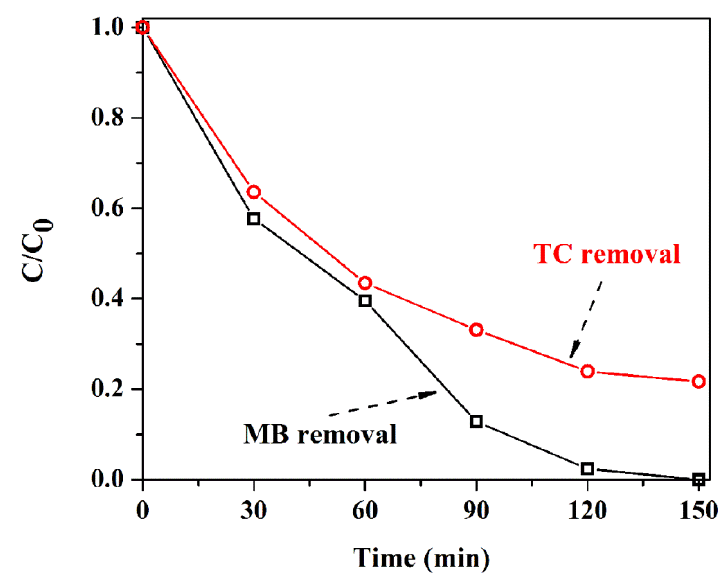
Figure 6. Methylene blue (MB) (20.0 mg / L, 100.0 mL) and tetracycline hydrochloride (TC) (20.0 mg / L, 100.0 mL) degradation curves over the Bi 2 WO 6 / CMS-2 composite.